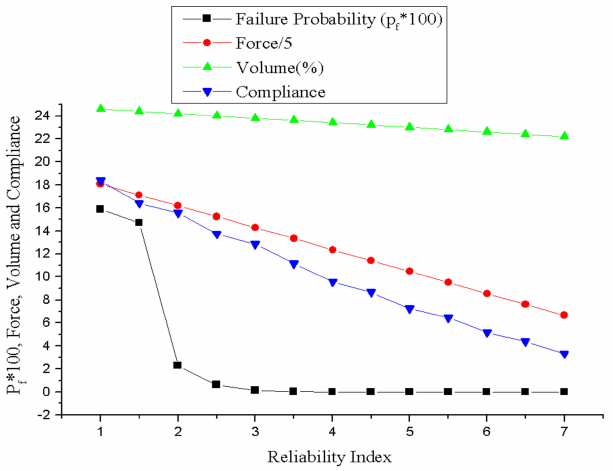
Figure 17. Failure probability and random variables by reliability